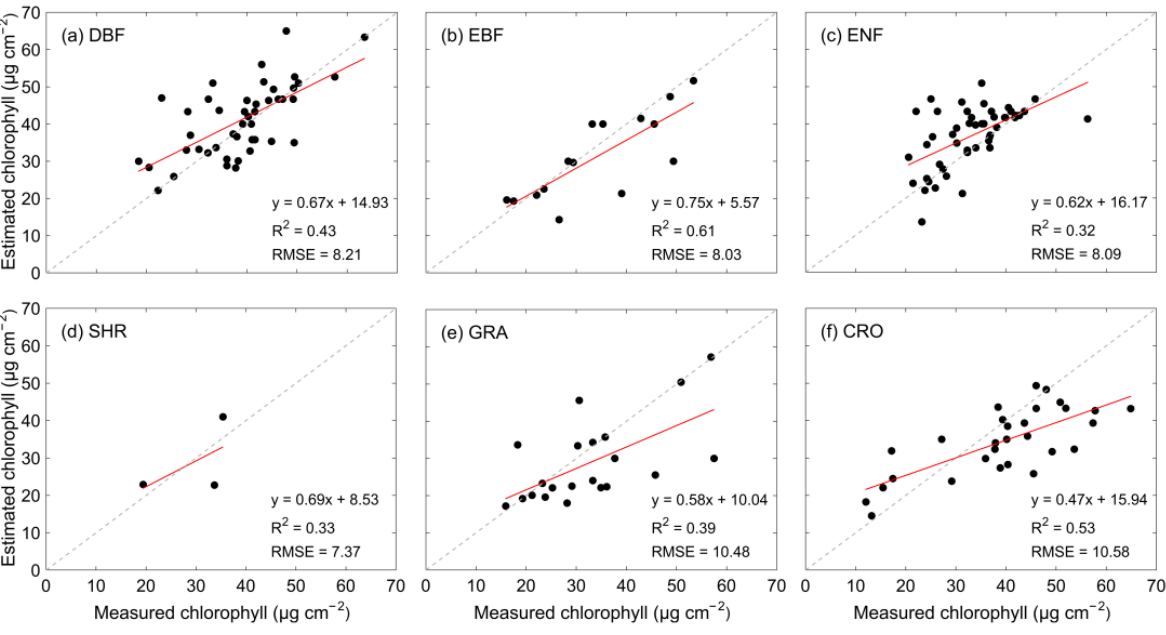
Figure 6. Validation of the GLCC dataset with field measurements for six individual PFTs.